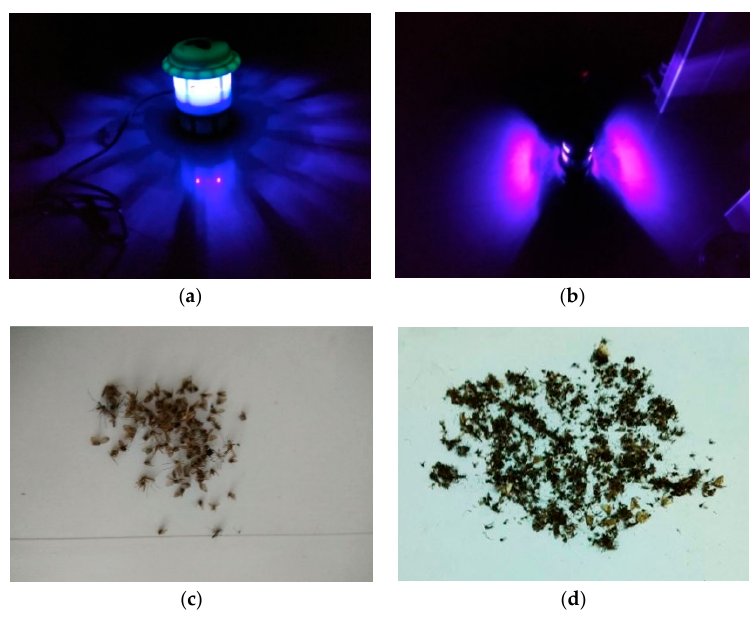
Figure 9. Experimental results of ( a ) purple blue LED mosquito trapper and ( b ) UV LED mosquito trapper with 150° SFL module. Total number of trapped mosquitoes (May 20–26, 2018, outdoors); ( c ) 278 for purple blue LED trapper and ( d ) 943 for UV LED trapper.